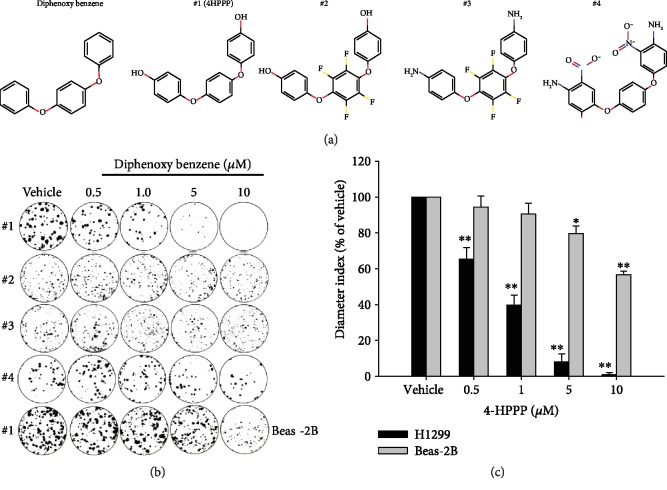
The inhibitory effect of compounds on the long-term proliferation of NSCLC cells. NSCLC H1299 cells and BEAS-2B human bronchial epithelial cells were treated with the indicated concentrations (from 0.5 to 10 μM) of tested compounds for 14 days. Afterward, the cells were paraformaldehyde-fixed and stained with crystal violet. (a) Chemical structures of 4-HPPP and its structural analogs. (b) Representative results of the colony formation of H1299 and BEAS-2B cells following compound treatment. (c) The quantitative results of (b) were statistically analyzed with one-way ANOVA. ∗p < 0.05; ∗∗p < 0.001. Vehicle control vs. 4-HPPP treatments. #1: 4-HPPP; #2: 4-[2356-tetrafluoro-4-(4-hydroxyphenoxy)phenoxy]phenol; #3: 4-[4-(4-aminophenoxy)-2356-tetrafluorophenoxy]aniline; #4: 4-[4-(4-amino-3-nitrophenoxy)phenoxy]-2-nitroaniline.